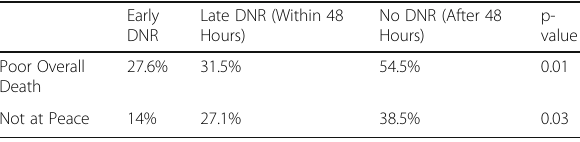
Table 1 (abstract 0047). Patient Quality of Death by DNR